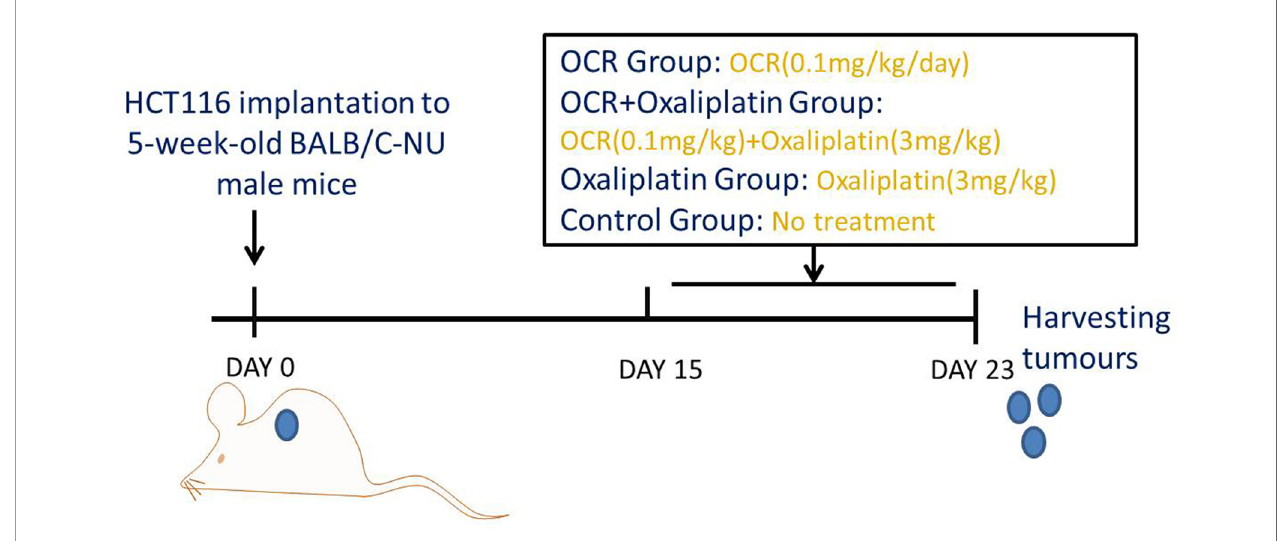
FIGURE 1 | Animal study